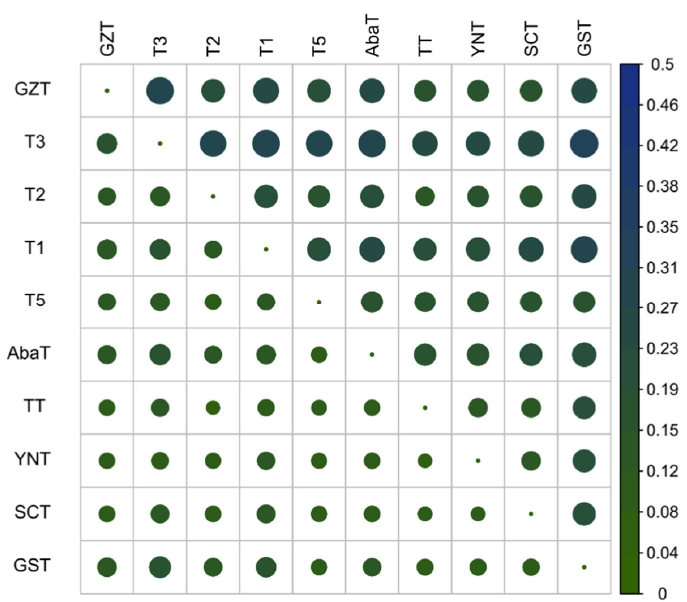
Figure 2. Heatmap plot of Nei’s minimum genetic distance D nei ( upper ) and gene frequency di ff erentiation index F ST ( lower ).